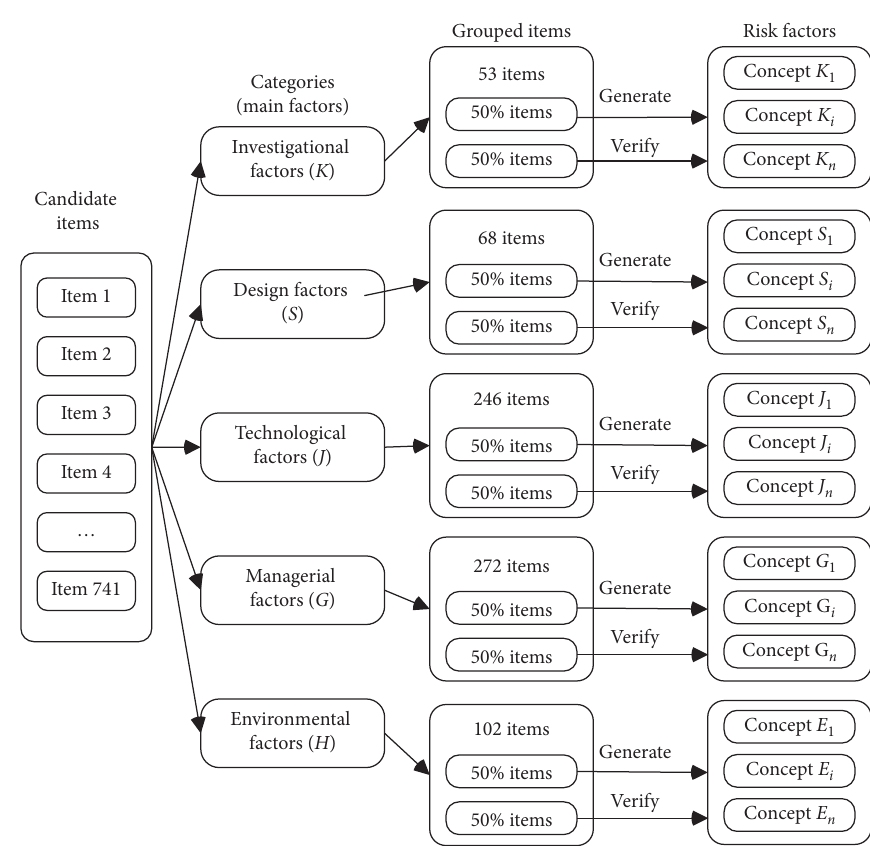
Figure 2: Three-stage procedure for risk factor identification.